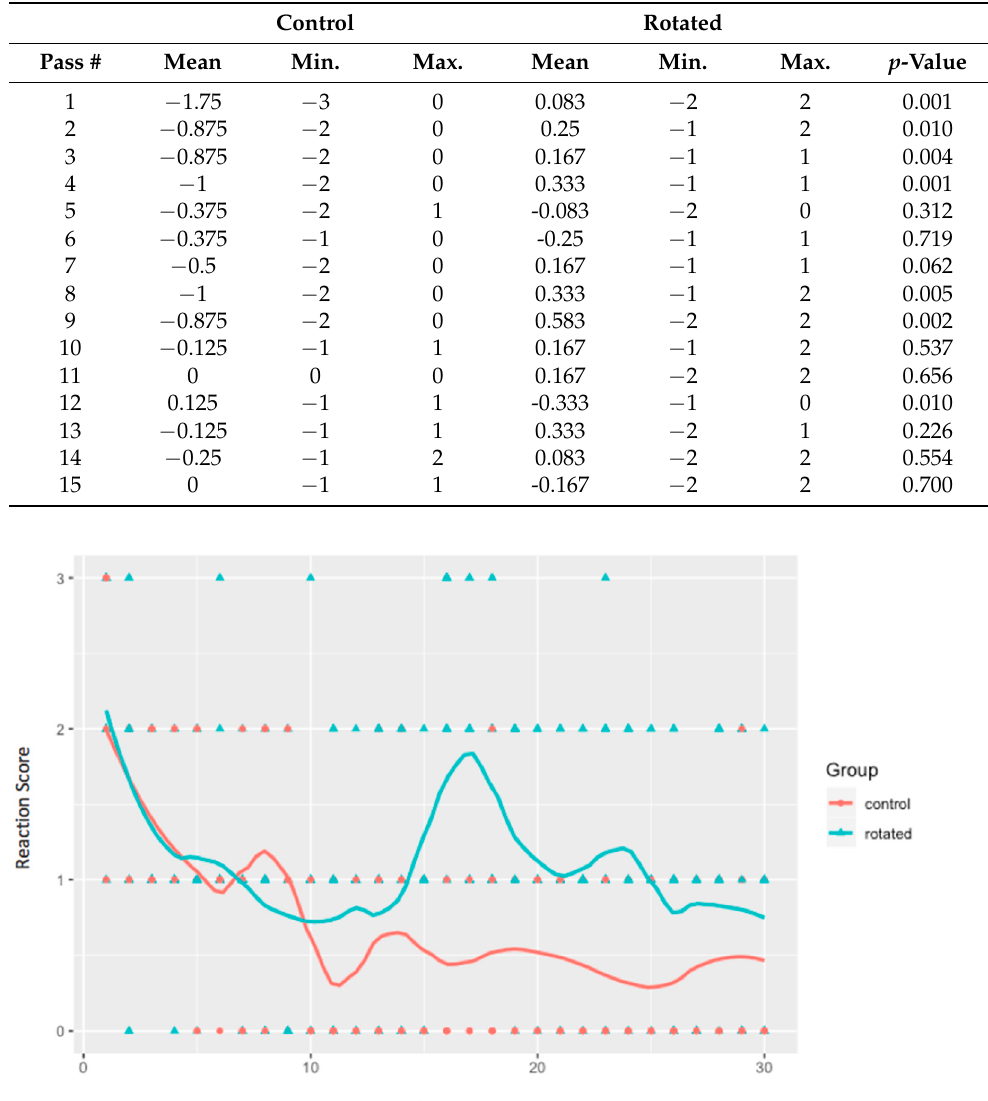
Table 4. Values for differences in reaction score for corresponding passes 1–15 by the novel object to